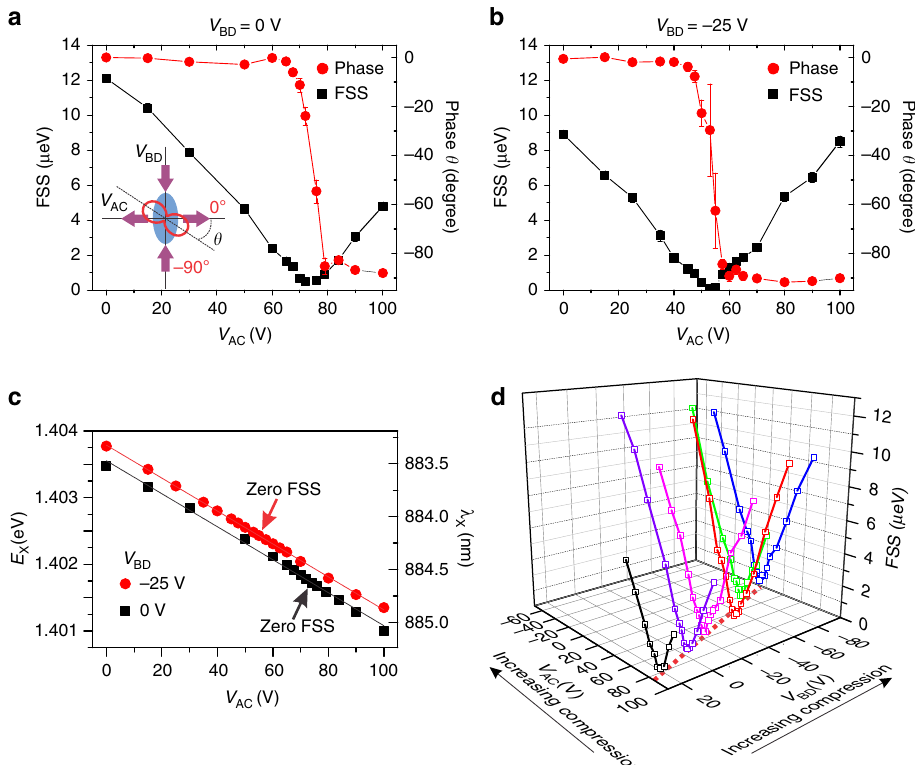
Figure 2 | Anisotropic strain engineering of a QD under orthogonal uniaxial stresses. ( a , b ) FSS and phase y are plotted as a function of the voltage V AC at a fixed voltage V BD of 0 and (cid:2) 25V, respectively. With the increasing voltages on legs A&C, FSS decreases monotonically to around zero and then increases again. And the phase shows an abrupt change from 0 to (cid:2) 90 (cid:2) , when FSS reaches the minimum value. The inset in a gives the definition of y . The ellipse indicates an elongated QD with its major axis aligned along a crystallographic direction. The red solid line indicates the exciton polarization. The error bars originate from the fitting process. ( c ) Exciton wavelength is plotted as a function of V AC for the two different V BD . The solid lines are linear fits. The arrows indicate exciton wavelengths at which the FSS are erased. ( d ) The changes in FSS when both V BD and V AC are scanned. The dashed line on the bottom plane indicates a linear shift of the voltage combination ( V AC , V BD ) at which FSS reaches the minimum values.